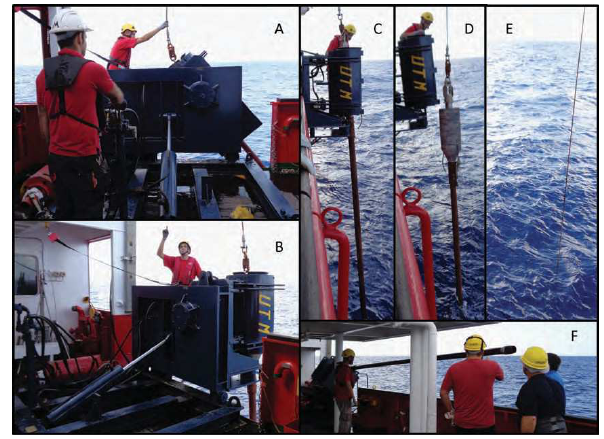
Figure 16. A and B - Detail cradle of gravity corer on the starboard deck; C, D and E - Launching the gravity corer; F - gravity corer on deck ready for extracting PVC jacket with the sedimentary record